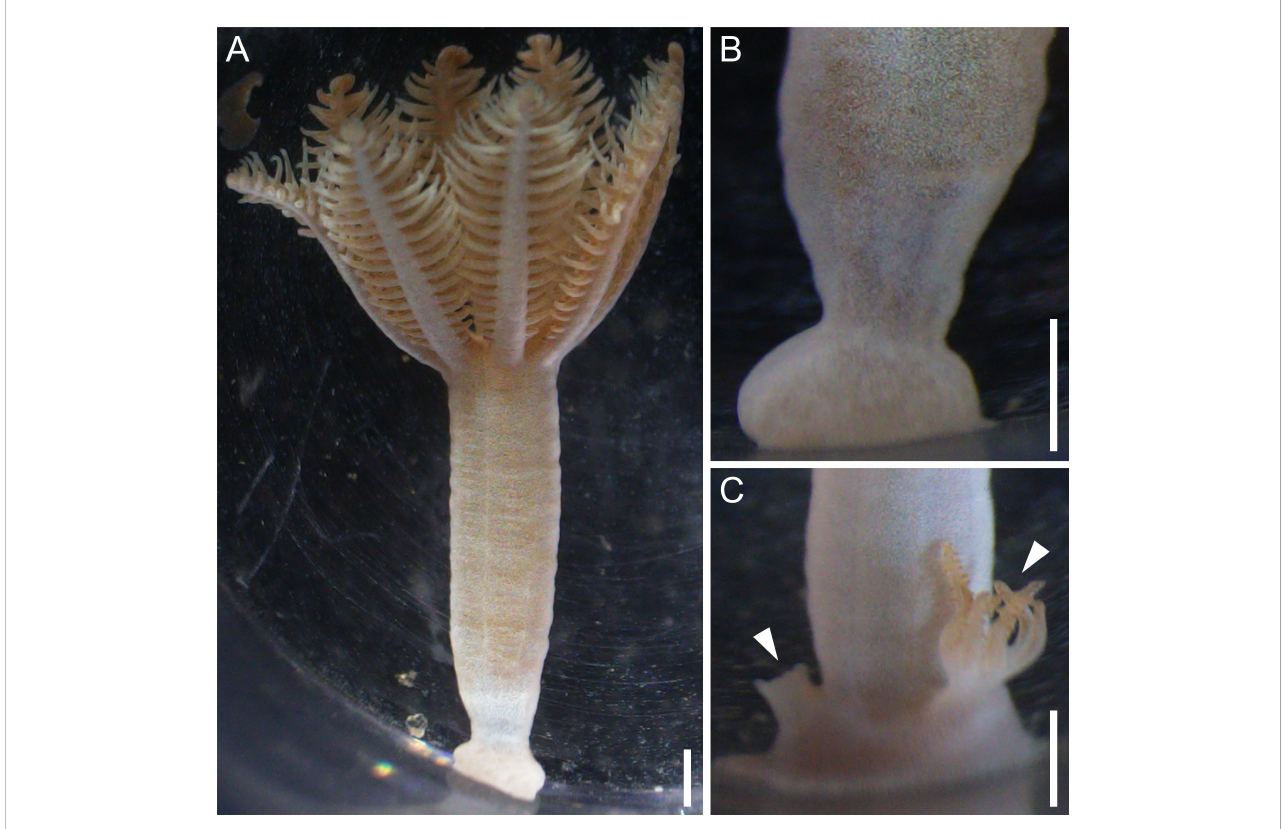
FIGURE 1 Polyp reattachment and budding in Xenia umbellata . (A) Polyp amputated from colony, reattached in tissue culture plate. (B) Close-up of basal attachment disc. (C) Daughter buds (arrowheads) forming from basal attachment disc. Scale bars 1